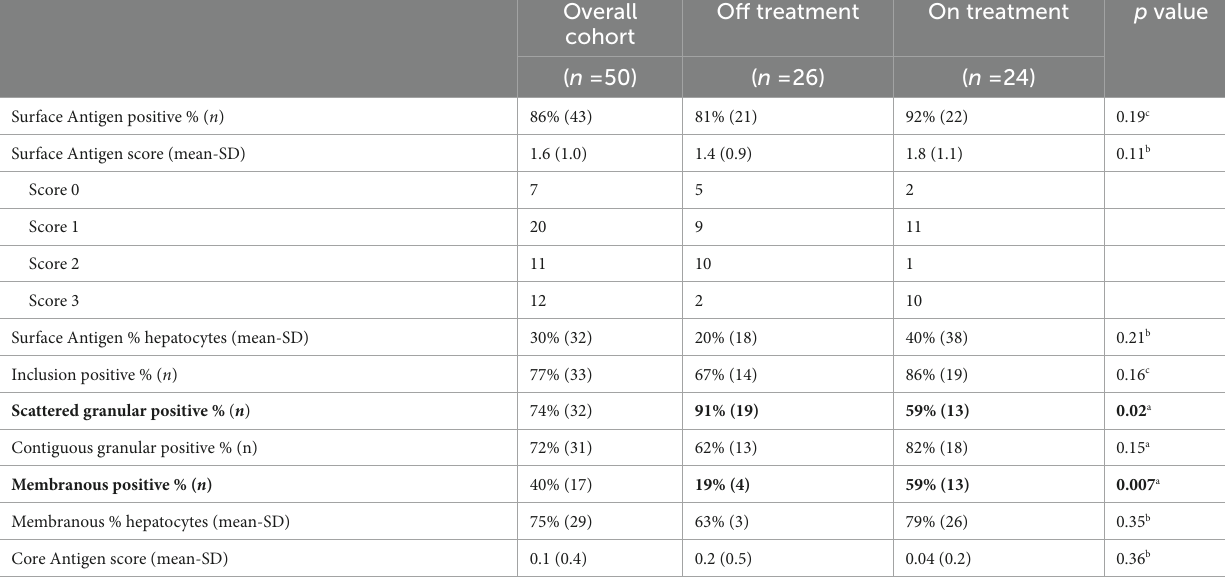
TABLE 2 Hepatitis B histological staining patterns compared between On and Off treatment groups.